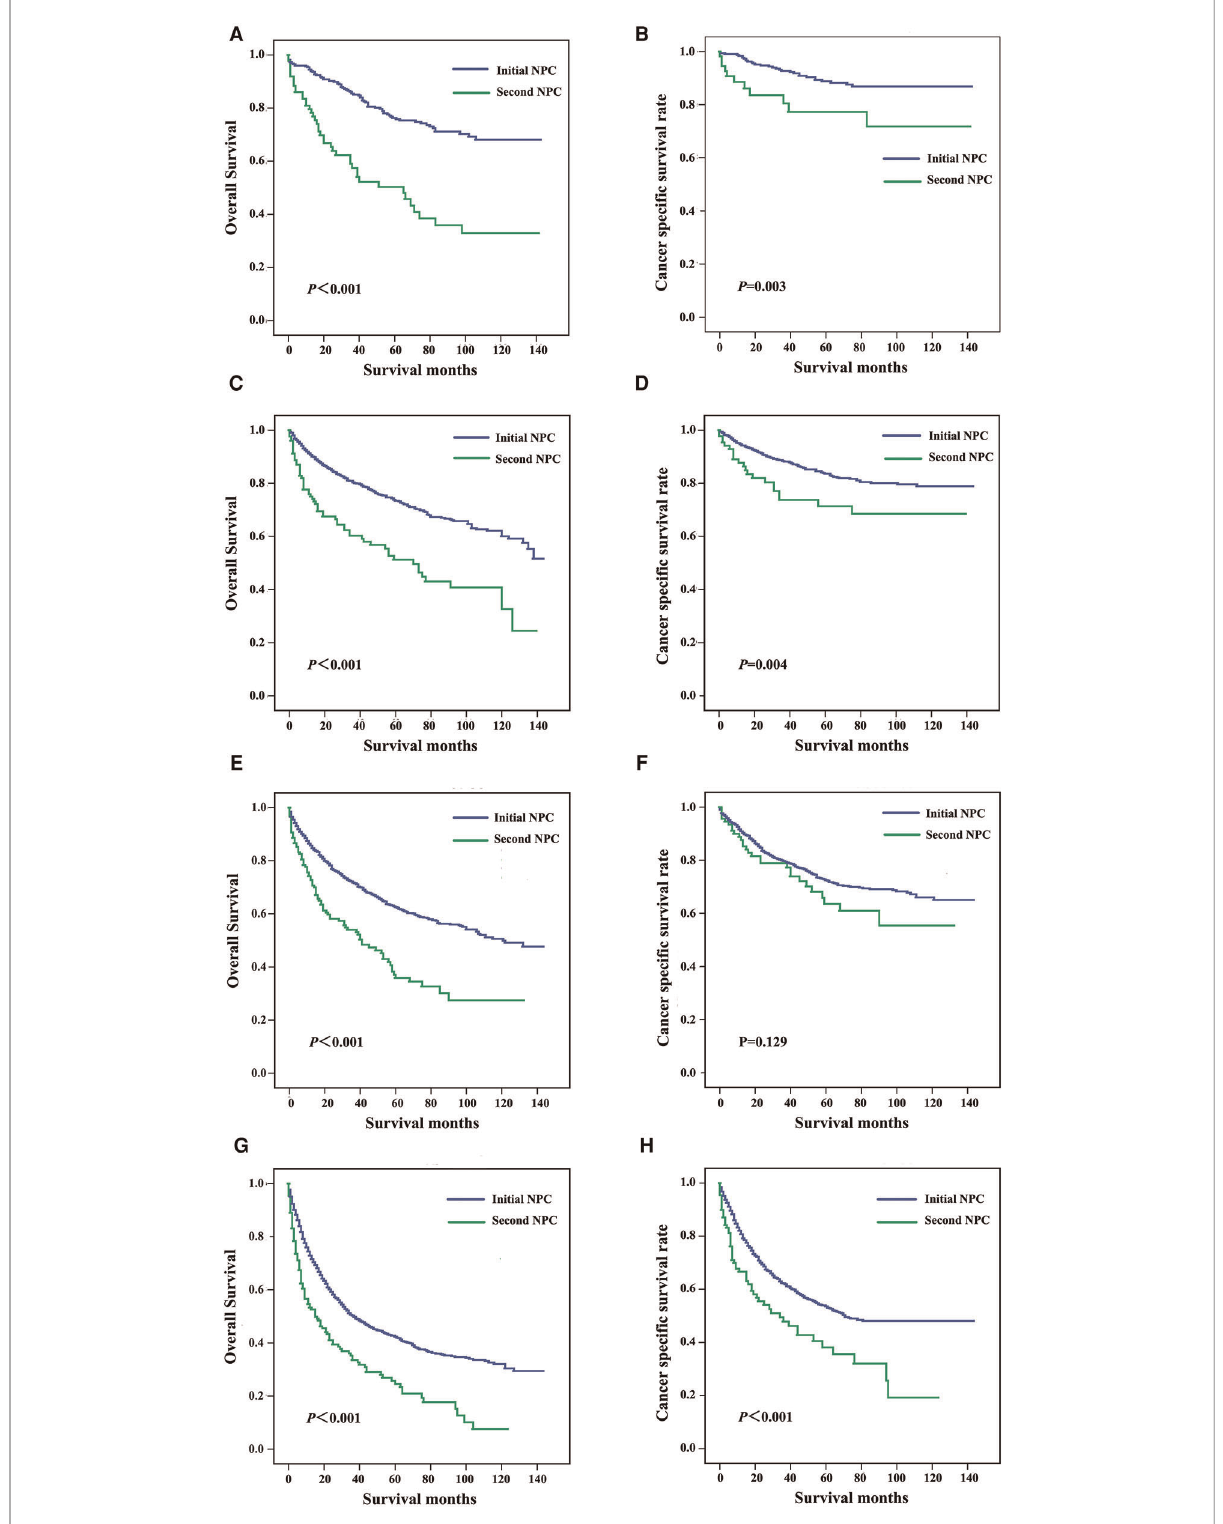
FIGURE 3 Survival curves for patients subgrouped by AJCC stage, including stage I ( A,B ), stage II ( C,D ), stage III ( E,F ), and stage IV ( G,H